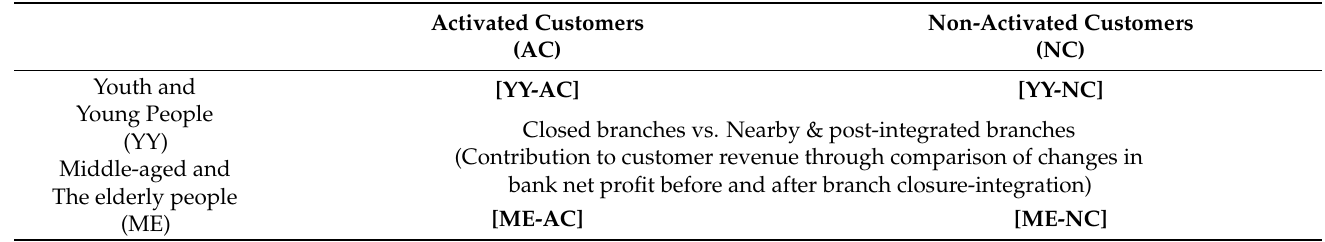
Table 7. 2 by 2 Hybrid model for H1